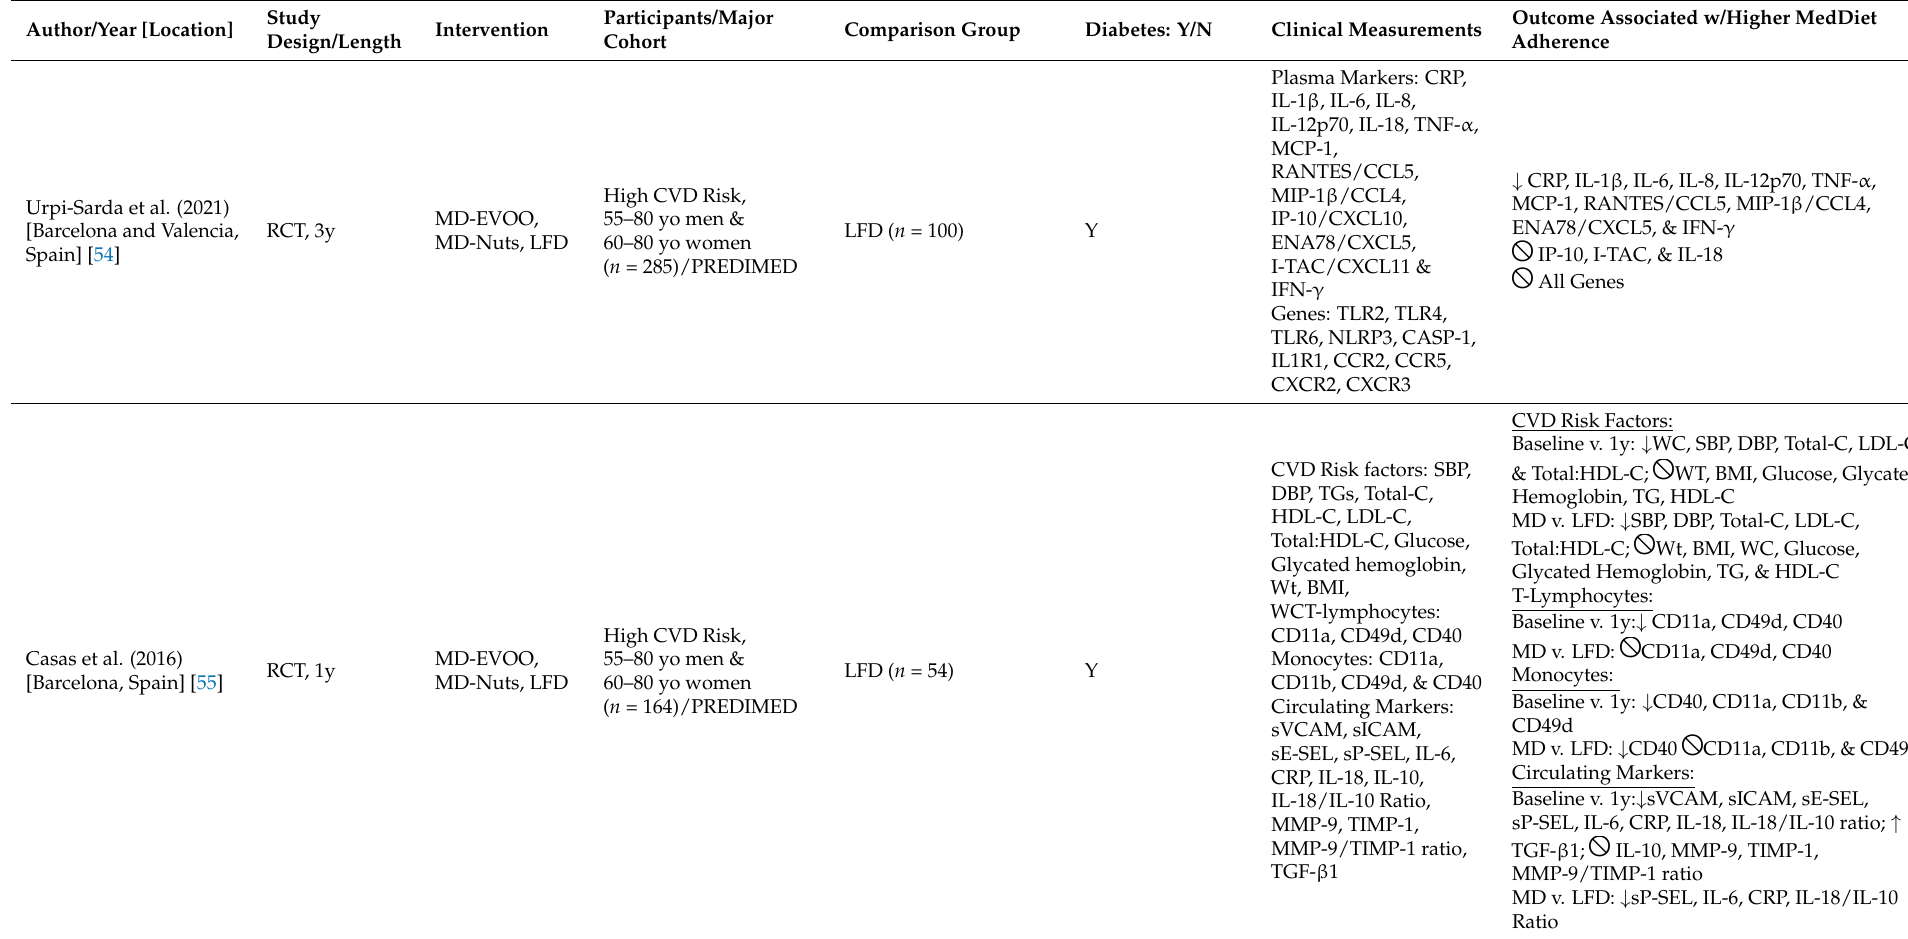
Table 2. Clinical Studies.